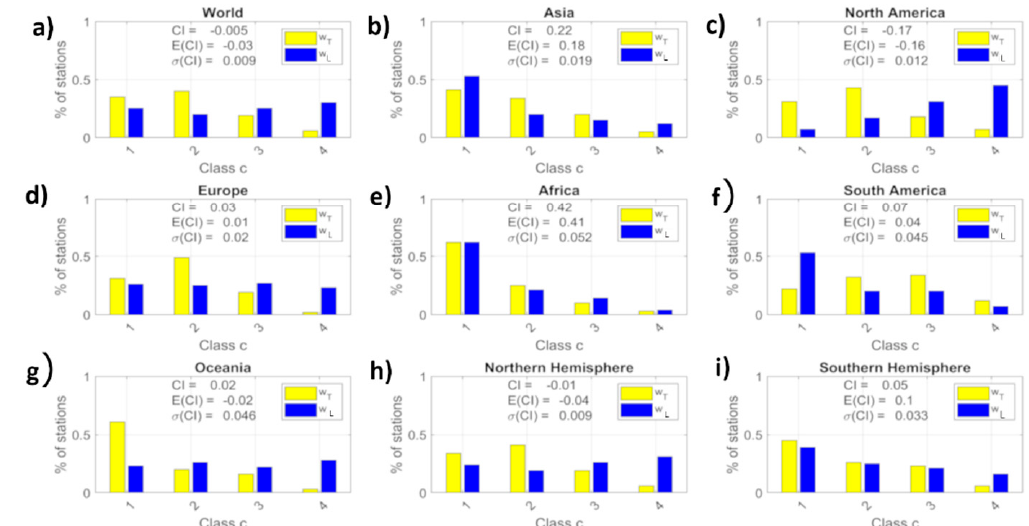
Figure 6. Spatial distribution of statistic indicators of temperature and nightlights trend with a 3 × 3 km buffer approximately. Main panel: standardized z values (Equation (16)) at the continental scale ( a – i ) probability of occurrence w of classes of significance from 1 (++) to 4 (–), where CI: concordance index (Equation (13)). E [CI]: expected mean of CI (Equation (14)). σ [CI]: standard deviation of CI (Equation (15)). w T : yellow bars, w L : blue bars.